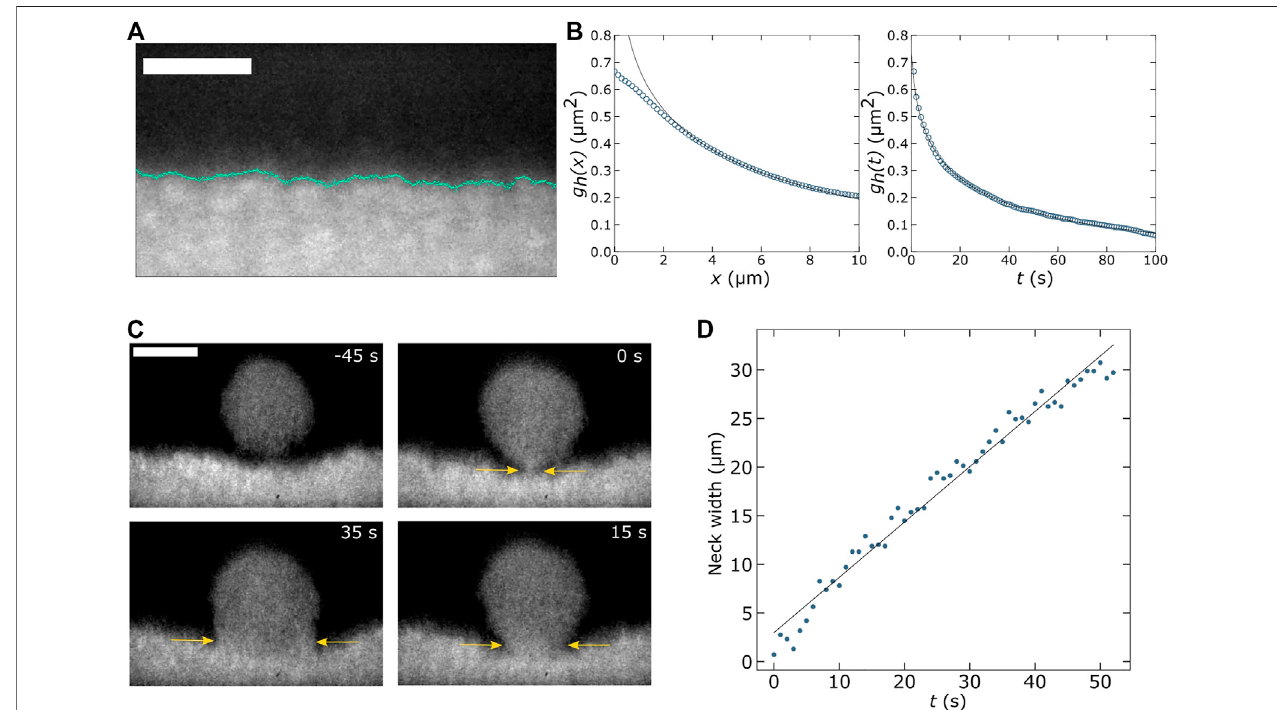
FIGURE2 |(A) Using theOPMsetup shown in Figures 1D,E wemeasure thermally fl uctuating capillary wavesin aphase separated colloid-polymer mixture. This mixture consists of ∼ 330-nm-diameter fl uorescent poly(N-isopropylacrylamide) microgel particles and xanthan, as described in our early work [73]. Scale bar is 20 µm. (B) After tracking the liquid-gas interface over a lateral distance of 78 µm for 700 s, we compute the height-height correlation function, g h ( x , t ) , and fi t it to the capillary wavemodelasdescribedinRef.64.We fi ndacapillarylengthofapproximately20 µmandacapillarytimeofapproximately200 s. (C) Imagesatfourdifferenttimes of a colloid-rich liquid droplet merging with a bulk liquid phase. Images are from volumes acquired at a rate of 1 Hz as described in the main text. Scale bar is 20 µm. (D) From the images of the droplet coalescing, we fi nd the neck width as a function of time. From the slope of this curve, we fi nd that the neck grows at approximately 0.3 μ